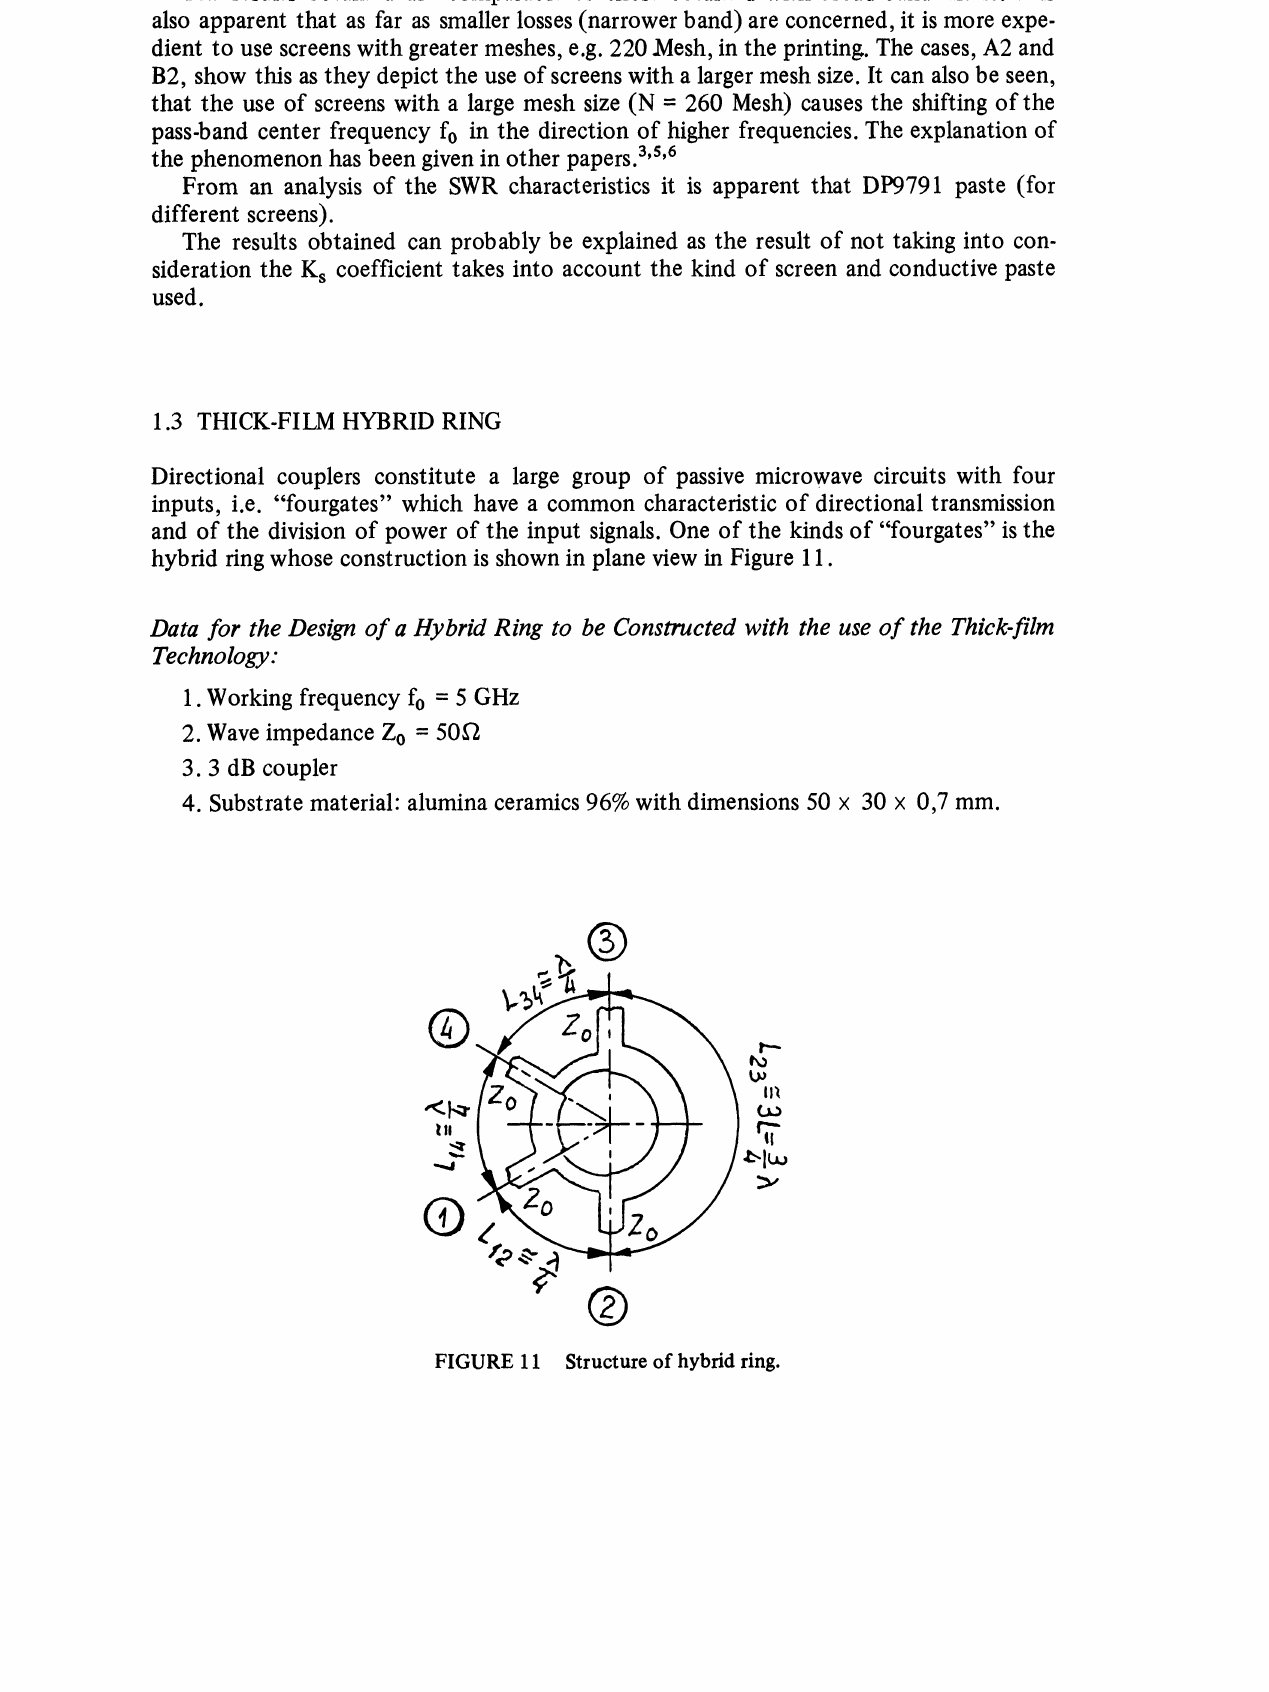
FIGURE 11 Structure of hybrid